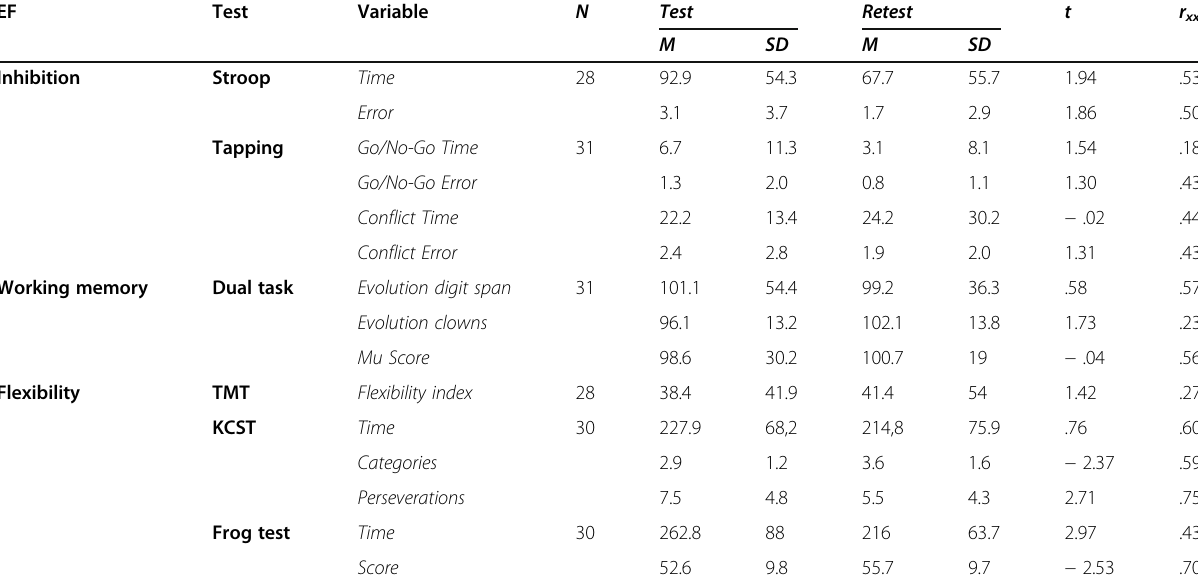
Table 3 Reliability coefficients obtained through the test-retest method EF Test Variable Inhibition Stroop